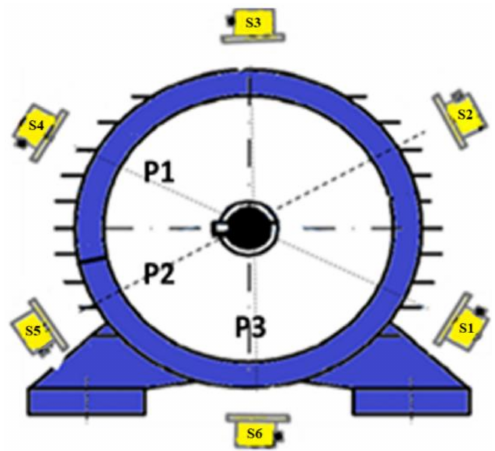
Figure 1. Sensors’ position around the machine